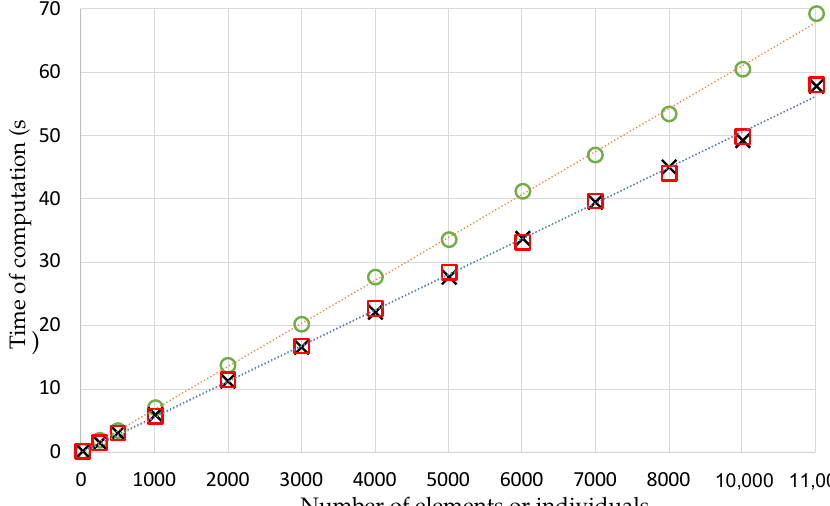
Figure 10. Time of computation required by the NPHC algorithm in terms of the number of elements or individuals used to construct the Pareto set. Red squares represent minimization of fuel cost–SO 2 , and black × represent minimization of fuel cost–NO x , and green circles represent minimization of fuel cost–SO 2 –NO x